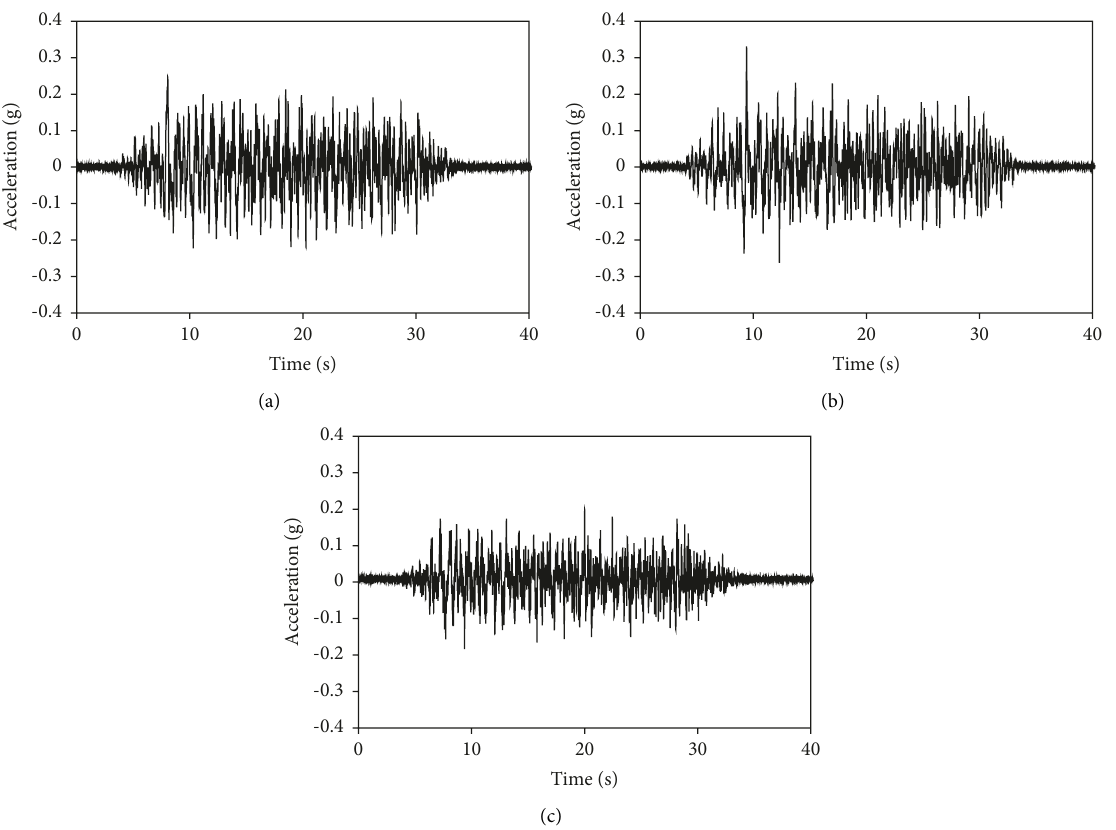
Figure 7: Initial input acceleration time histories in the X-, Y-, and Z-directions of the AC156_100 used in test specimen no. 5A. (a) X- direction. (b) Y-direction. (c) Z-direction.